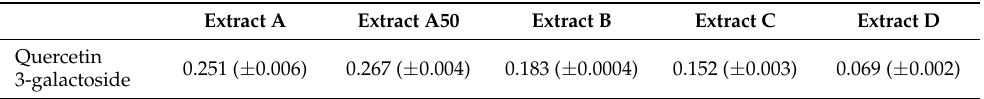
Table 12. Quercetin 3-galactoside absolute concentrations ( µ g/mL, mean ± SD) in the extracts.